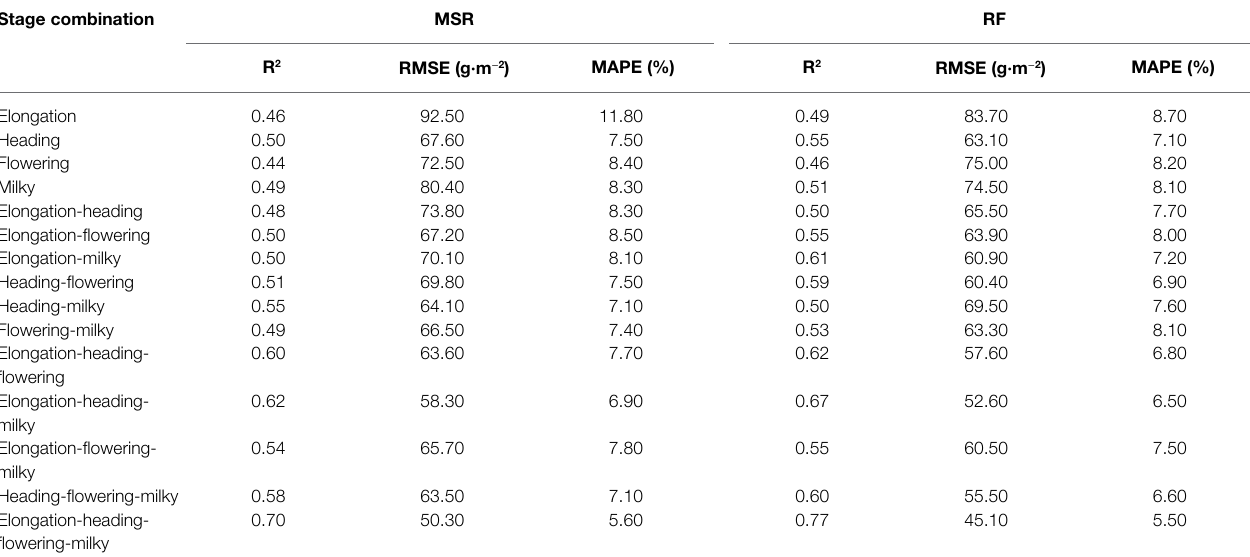
TABLE 5 | Rice yield prediction model based on first derivative transform. Stage